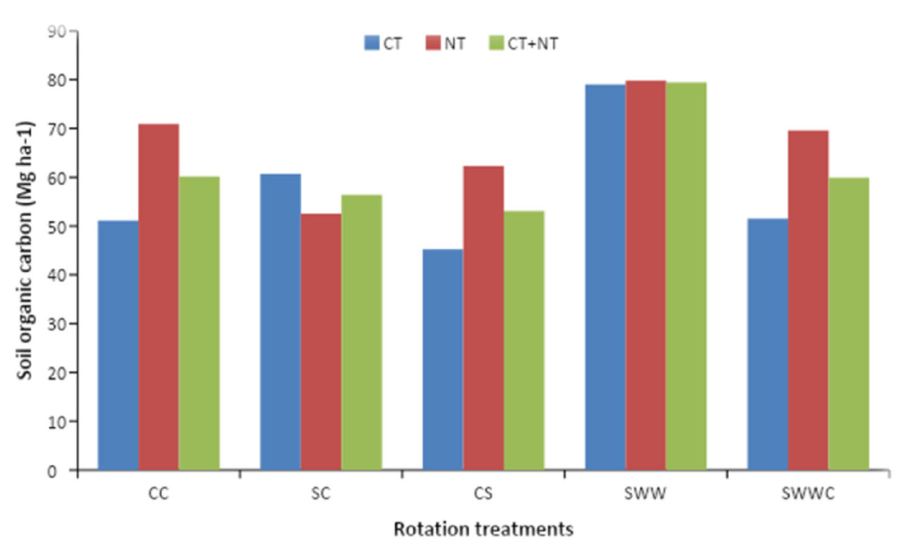
Figure 4. Effects of rotation treatments on SOC storage. CC—continuous corn, SC—soybean–corn, CS—continuous soybean, SWW—soybean–winter wheat, SWWC—soybean–winter wheat–corn, CT—conventional tillage, NT—no tillage. Authors’ elaboration based on [150].